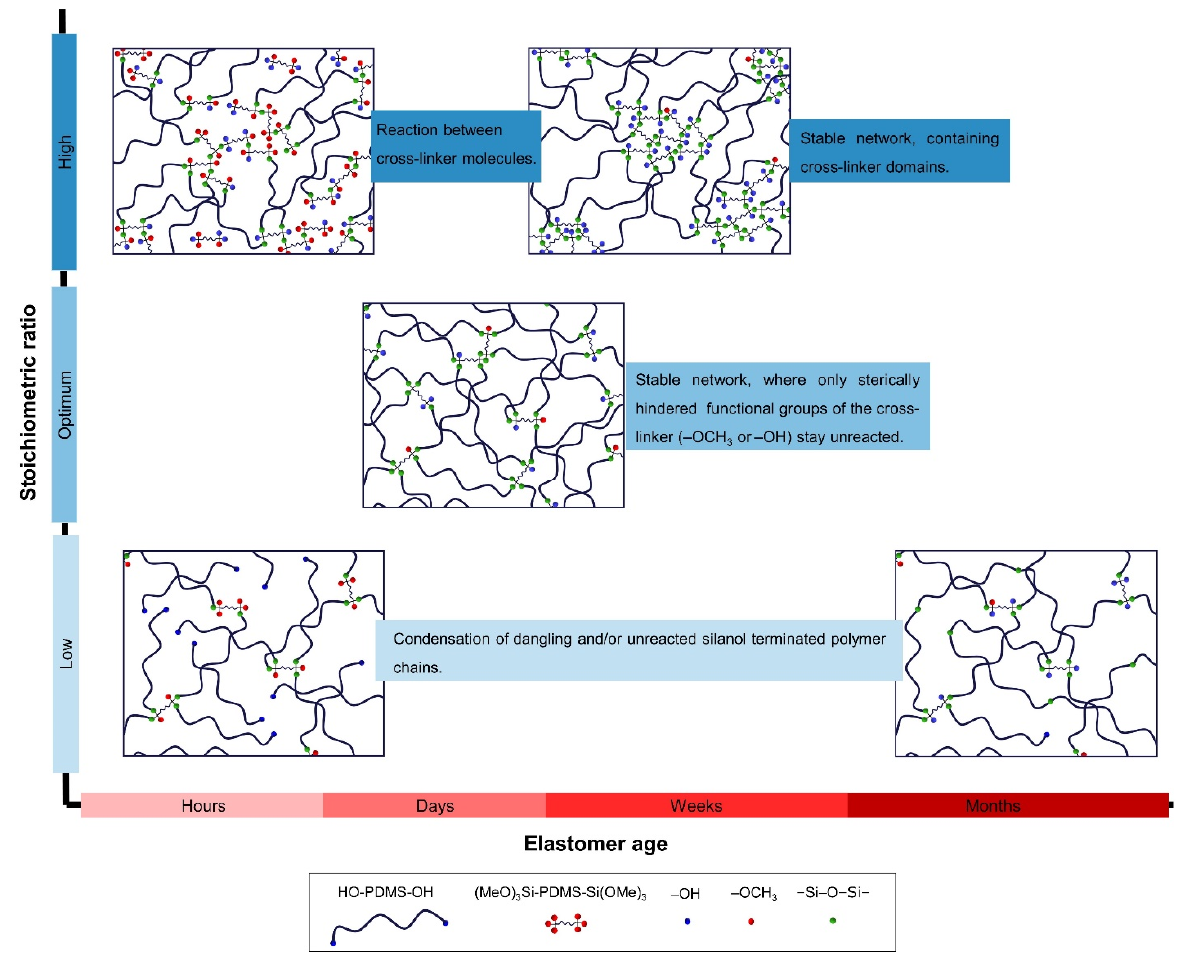
Figure 5. Schematic representation of the effects of stoichiometric ratio and elastomer age on elastomer network structure and stability.